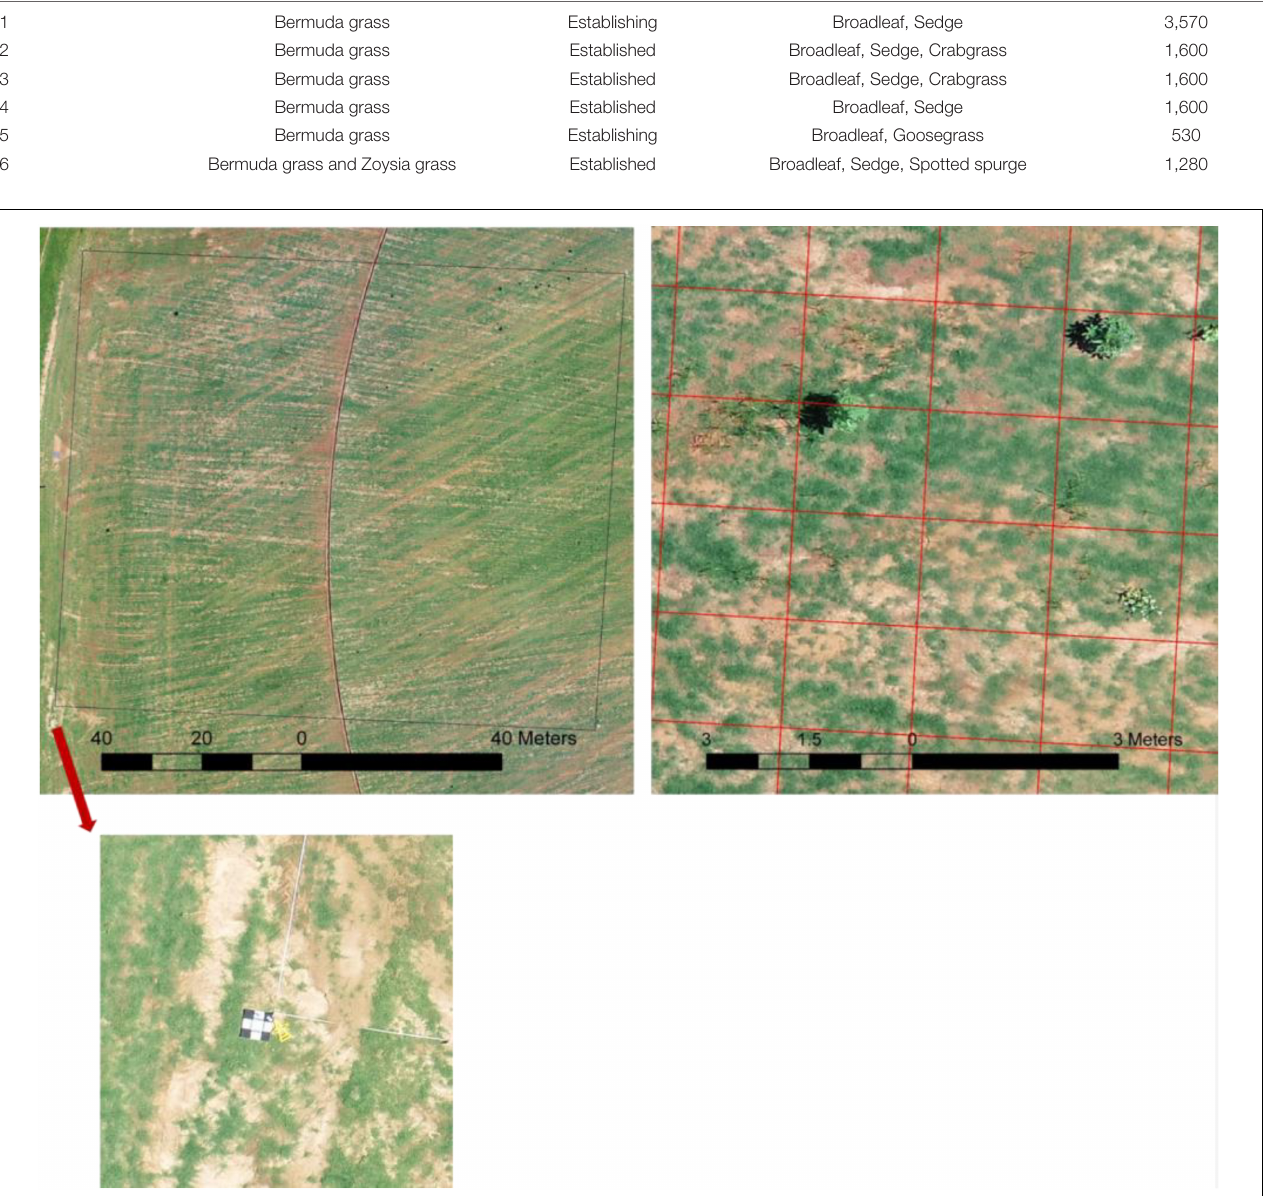
FIGURE 1 | Example of the survey area conducted on Georgia sod farm in 2019. Top left: overlook of the survey with the size of 91 m by 91 m outlined by the black box and the ground target placed on the southwest corner (bottom); top right: one small section of the survey with the grid overlaid.